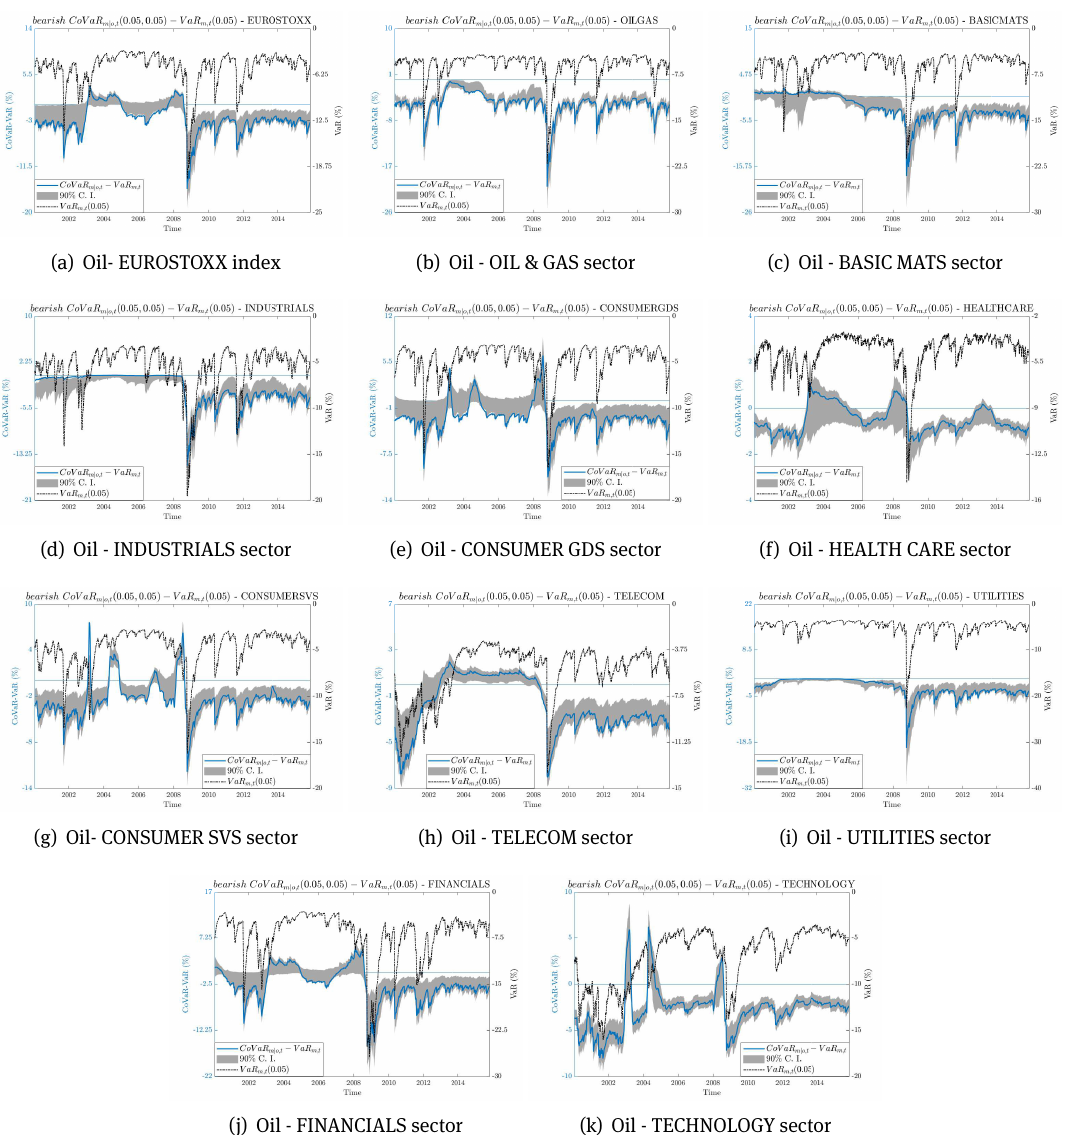
Left axis shows the difference in percentage between the CoVaR (0.05) of the returns for a certain sector under a extreme m , t downward movement in oil price, i.e. below its 5-th quantile, and its unconditional VaR (0.05). Solid blue line shows this m , t difference given the best copula mixture according to table 6. Grey area indicates the 90% confidence interval of the difference between CoVaR (0.05, 0.05) and VaR (0.05) following a Monte Carlo technique explained in Appendix C. The right axes m , t m | o , t shows the value of the VaR (0.05) in percentage. The dash-dotted black line indicate the VaR level over m , t